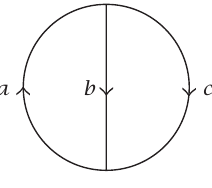
Figure 4.2 . Auxiliary diagrams for multiple ζ relations of length